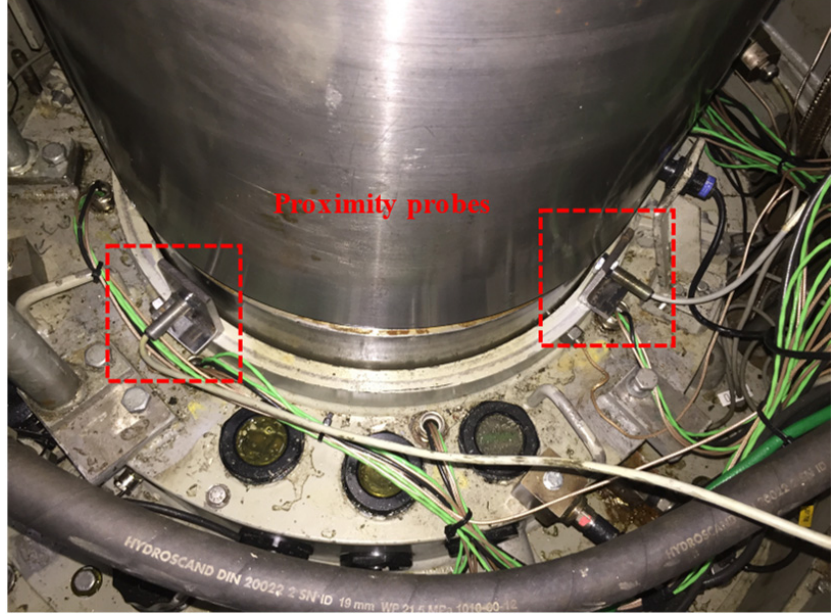
Figure 3. Location of the proximity probes installed close to the turbine guide bearing.